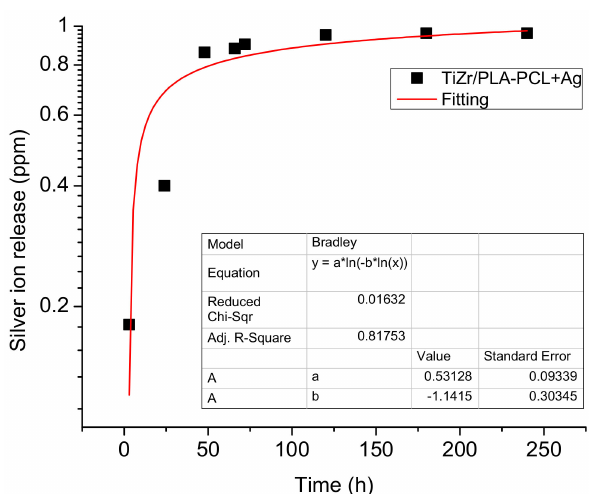
Figure 4. Ag ions release by Inductively Coupled Plasma Mass Spectrometry (ICP-MS) method.